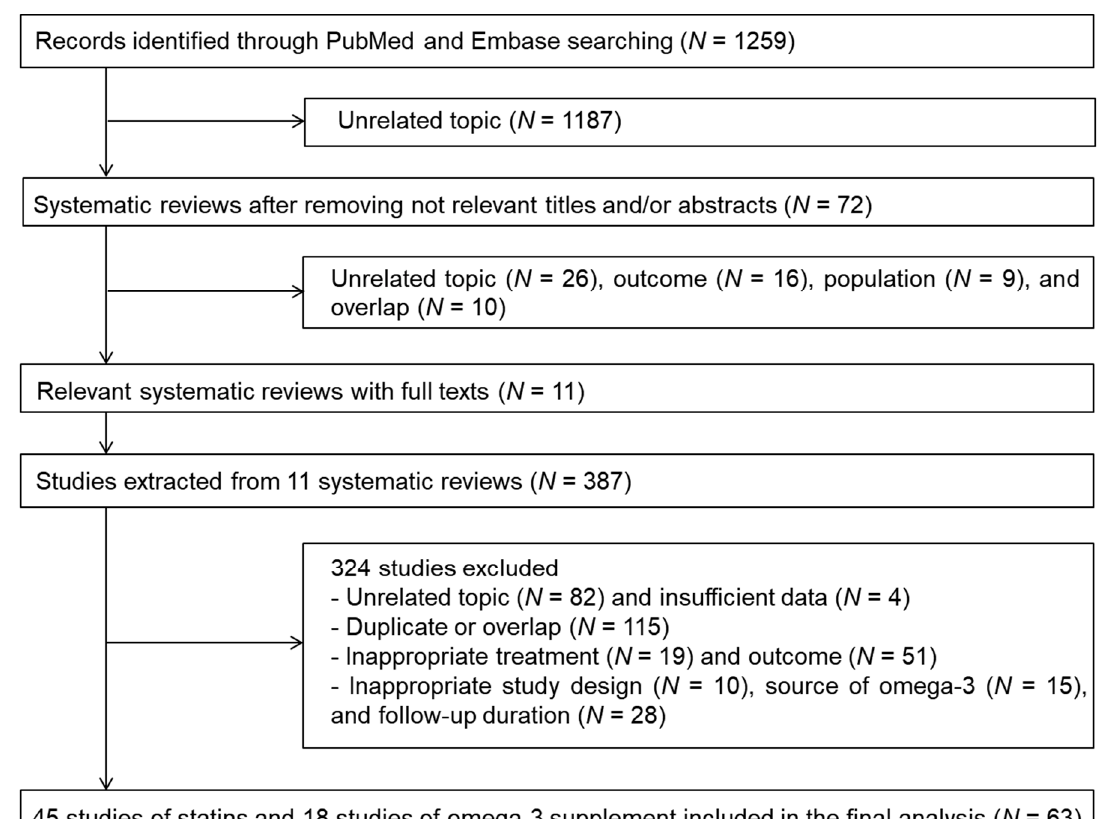
Figure 1. Flow diagram of the systematic review.